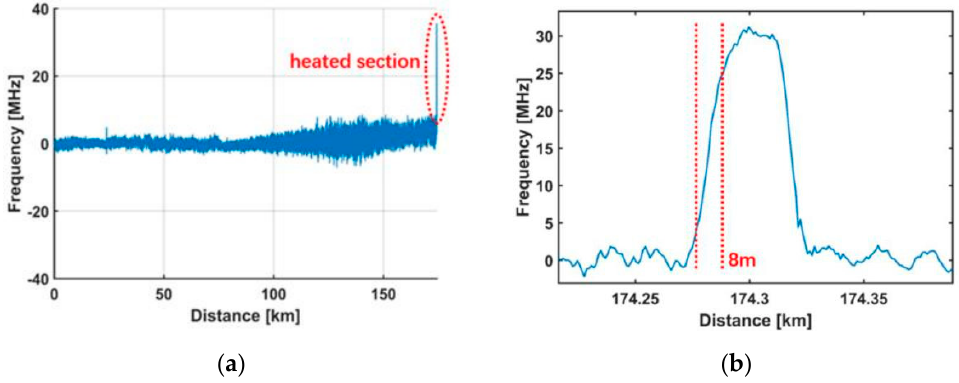
Figure 20. BFS difference versus distance. ( a ) Along the whole fiber; ( b ) around the heated section [127].